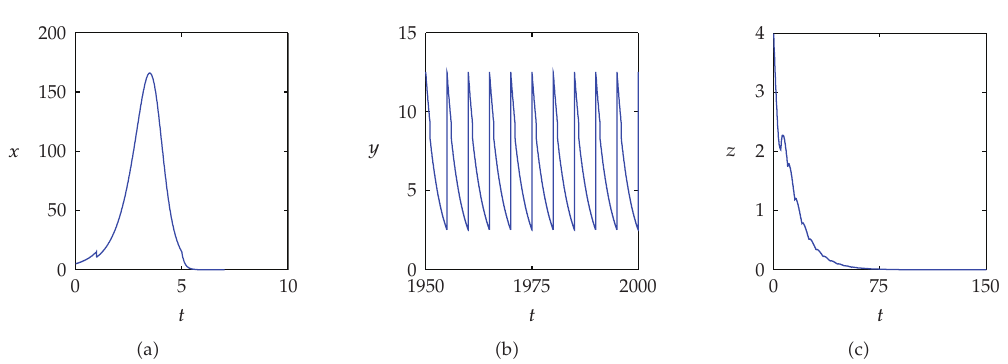
Figure 1: a (cid:7) 2 . 0, b (cid:7) 0 . 001, c (cid:7) 0 . 5, c 1 (cid:7) 0 . 01, d 1 (cid:7) 0 . 3, d 2 (cid:7) 0 . 2, e 1 (cid:7) 0 . 01, e 2 (cid:7) 0 . 02, p 1 (cid:7) 0 . 3, p 2 (cid:7) 0 . 1, p 3 (cid:7) 0 . 01, τ (cid:7) 0 . 2, and T (cid:7) 5. (cid:2) a (cid:3) – (cid:2) c (cid:3) Time series of system (cid:2) 1.2 (cid:3) when q (cid:7)